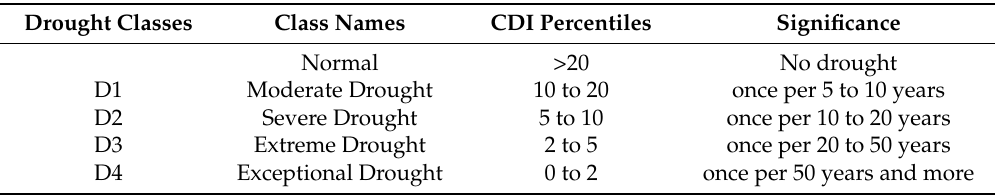
Table 2. Drought intensity